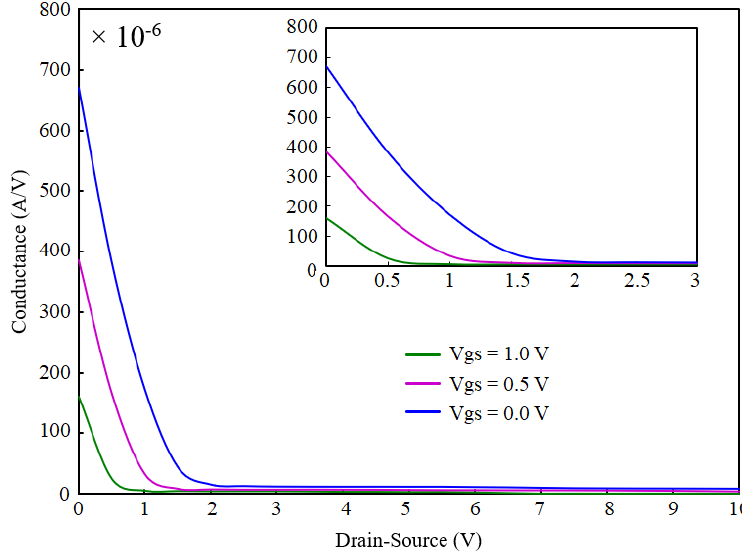
Figure 9. Change of conductance of OG ‐ JFET with back gate.